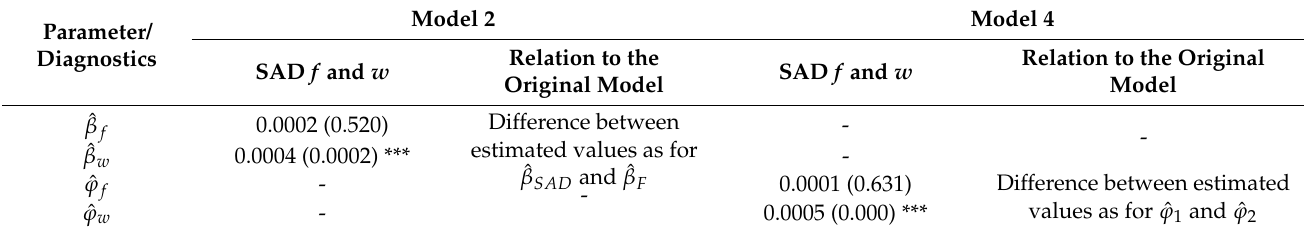
Table 6. Robustness check of results for Fall